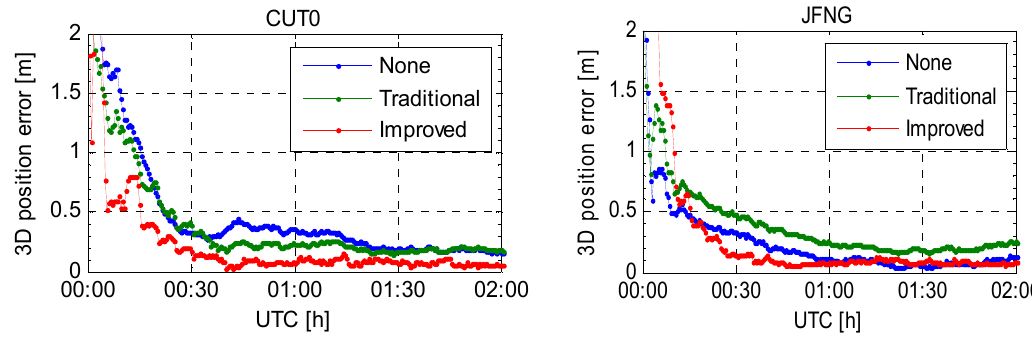
Figure 10. Epoch-wise PPP solutions of CUT0 and XMIS (DoY 130/2015).